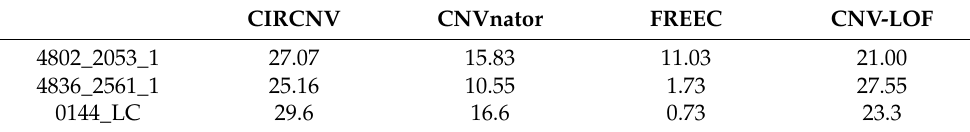
Figure 7. Venn diagrams to show the overlapping and non-overlapping CNVs between each pair of methods for each of the three tumor samples, EGAR00001004802_2053_1 ( I ), EGAR00001004836_2561_1 ( II ), and EGAD00001000144_LC ( III ). Table 1. Comparison of ODS values between the four methods on the two tumor samples.